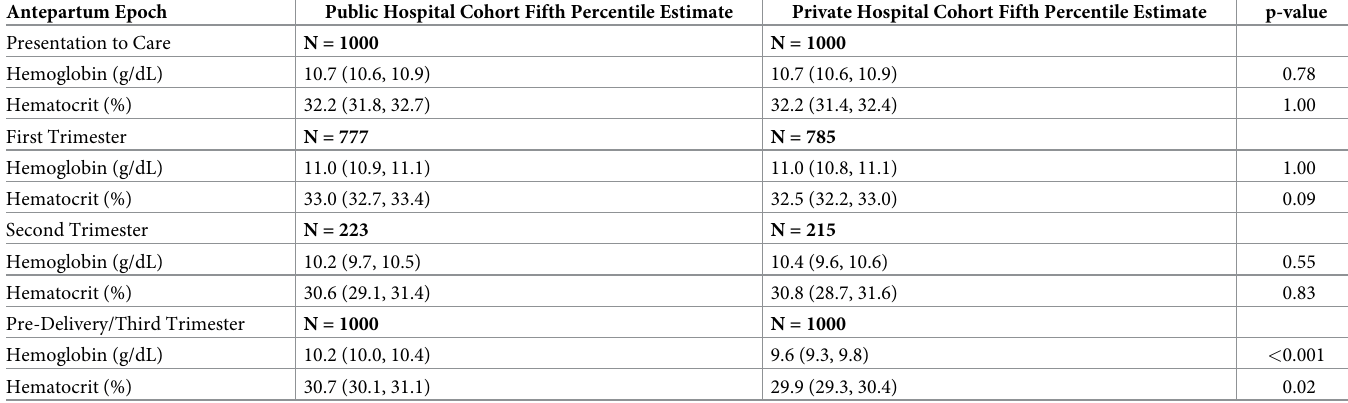
Data presented as Fifth Percentile Estimate (95% Confidence